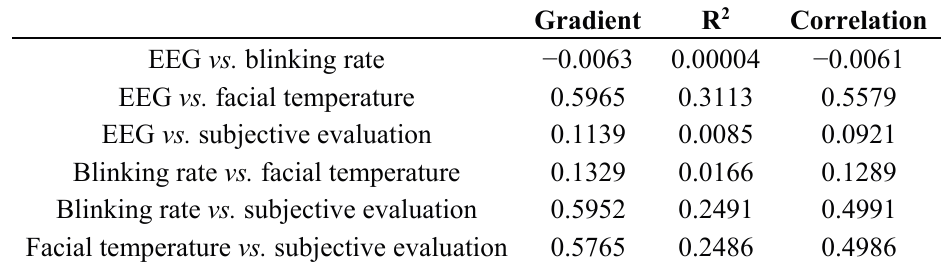
Table 9. Gradient, R 2 and correlation values between two modalities.